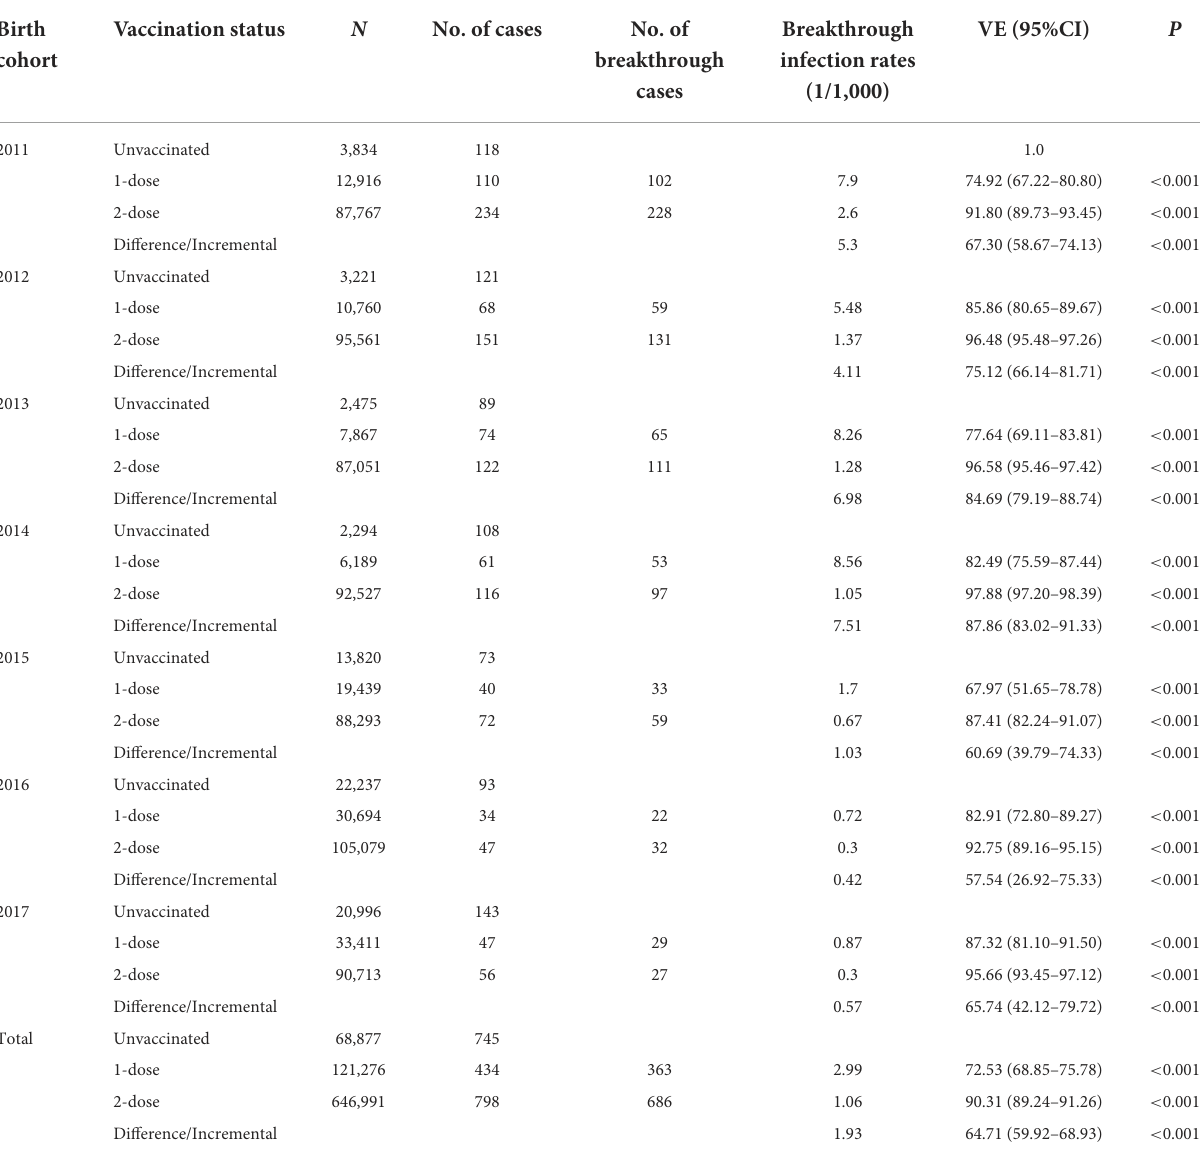
TABLE 2 The breakthrough infection rate and the effectiveness of the vaccine. Birth